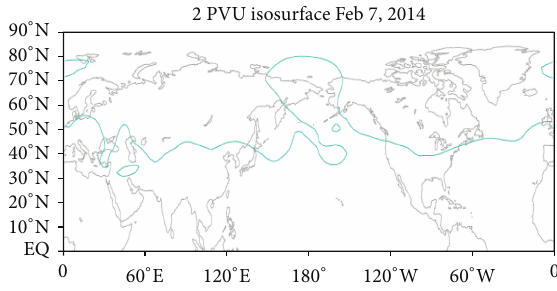
Figure 12: 2 PVU surface for February 7,